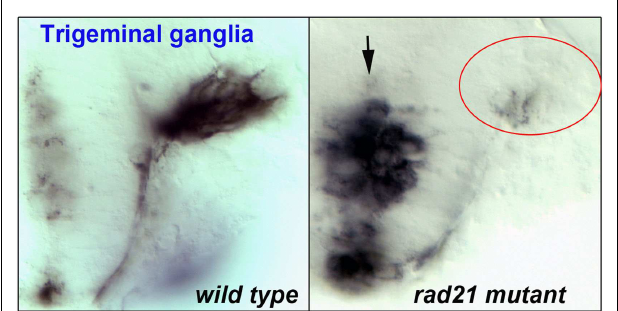
FIGURE 3 | Flat-mount staining (anti-HNK-1) of trigeminal ganglia in wild type (left) and rad21 mutant (right) zebrafish embryos. In rad21 mutants, central neuronal clumping occurred (arrow), and axons failed to migrate and populate anterior regions (red